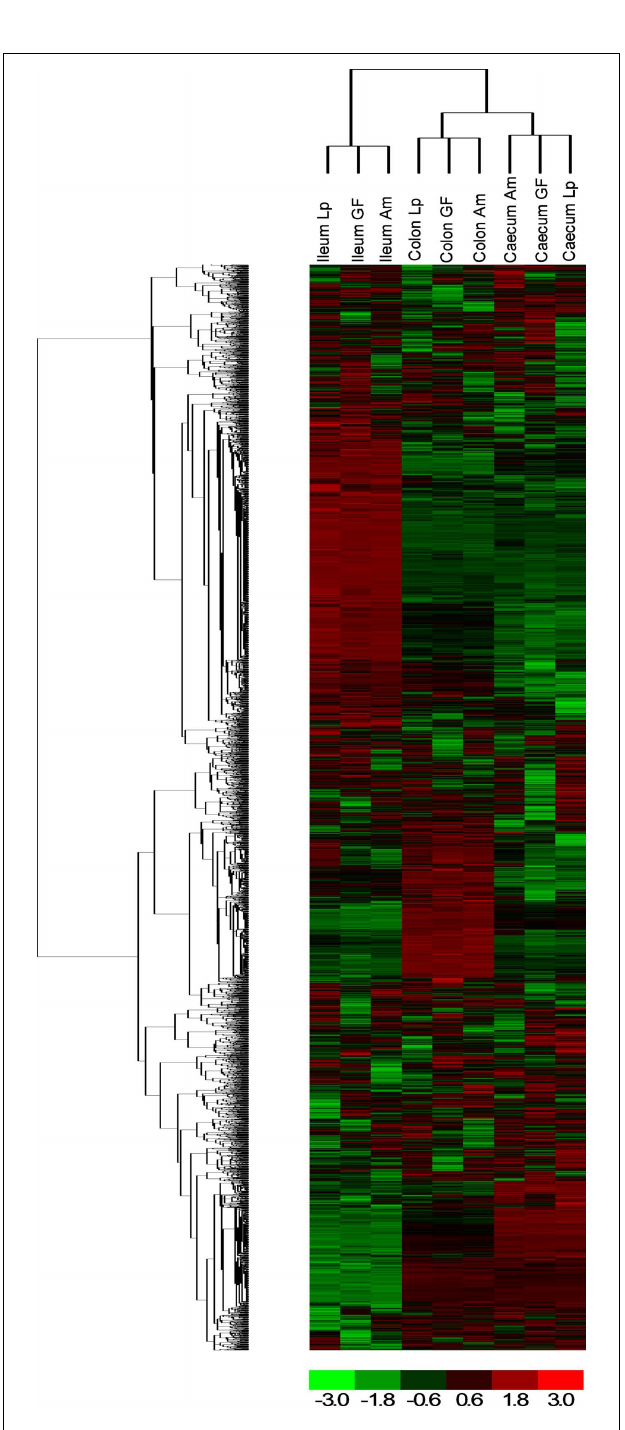
FIGURE 2 | Hierarchical clustering of genes obtained using D-Chip software. Hierarchical clustering was performed on intensity values generated by Affymetrix MAS 5.0 software, showing differential responses in the three locations (ileum, cecum, and colon) and with bacteria [ A. muciniphila (Am) and L. plantarum (Lp) compared to germ-free (GF) mice]. Each column corresponds to one array (pool of six RNA) and each frame corresponds to one probe set. Red corresponds to an up-regulation of the gene expression and green to a down-regulation. Black corresponds to no